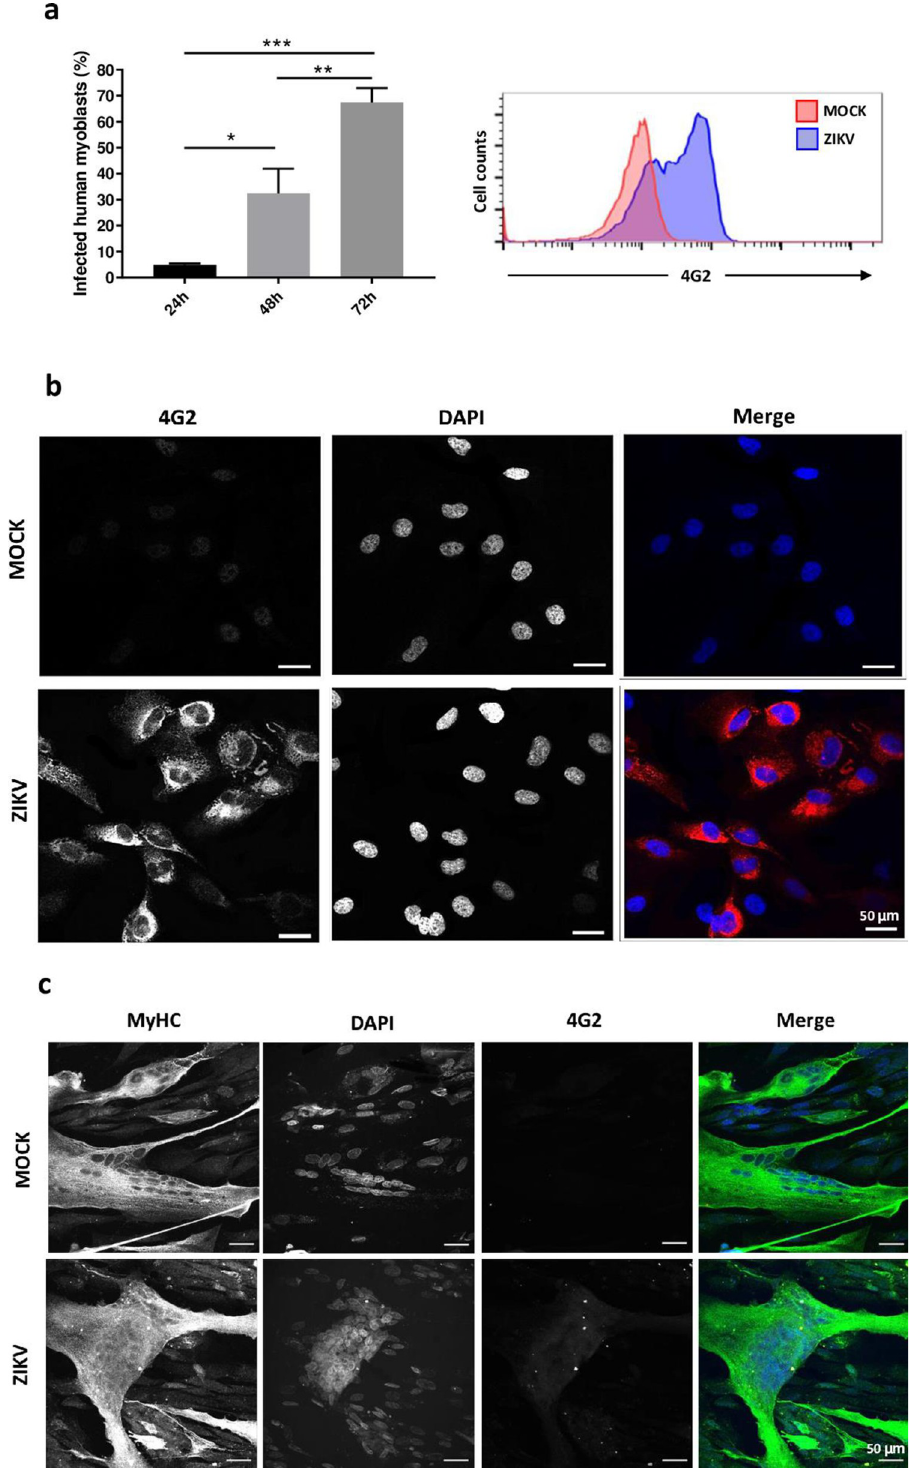
Fig 1. Human cultured myoblasts (but not myotubes) can be infected by Zika virus and generate intracellular viral particles. ( A ) The LHCN-M2 myoblast cell line was infected with ZIKV (MOI = 0.1), and the percentage of 4G2 + cells was detected 24- (n = 2), 48- (n = 2) and 72- (n = 4) hours post-infection by flow cytometry. Each time point is represented by mean ± standard error. Results were analysed by one-way ANOVA and Tukey post-test. � p < 0.05,